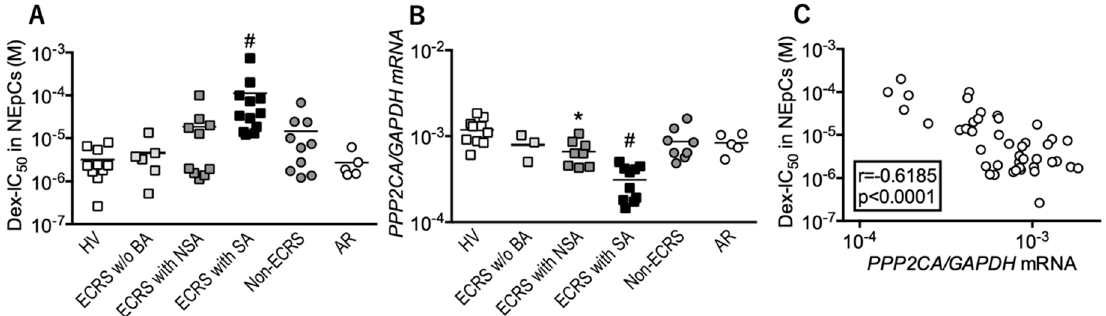
Figure 1. Responses to corticosteroids and protein phosphatase 2A (PP2A) expression in nasal epithelial cells (NEpCs). ( A ) IC 50 values for dexamethasone on TNF α -induced CXCL8 production (Dex-IC 50 ) were measured as a marker of corticosteroid sensitivity. ( B ) PP2A mRNA levels were determined using RT-PCR. ( C ) Correlation between Dex-IC 50 and PP2A mRNA levels. Individual values of patients in each group are shown. # p < 0.05 (vs. other groups), * p < 0.05 (vs. healthy volunteers). HV: healthy volunteers; ECRS: eosinophilic chronic rhinosinusitis; BA: bronchial asthma; NSA: non-severe